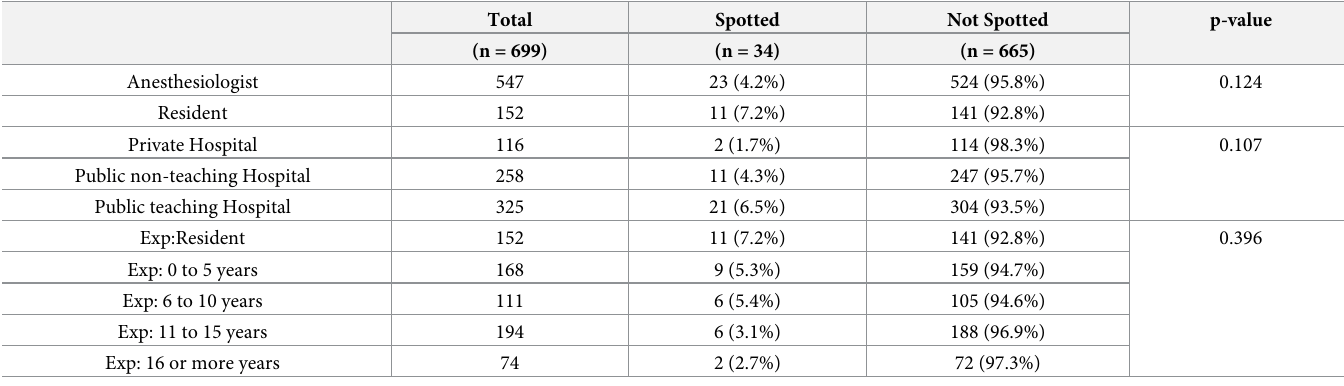
Table 1. Respondents